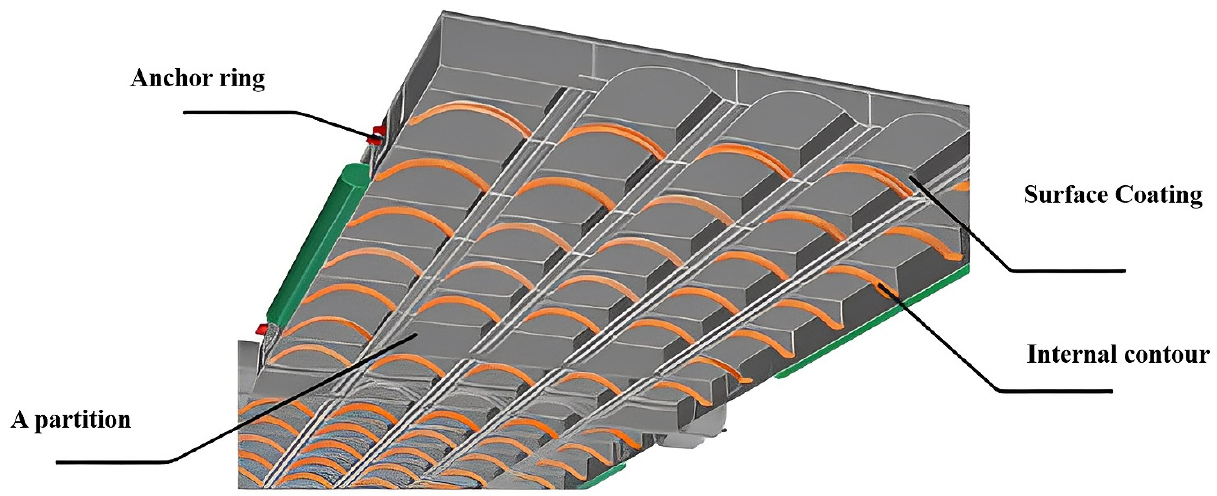
Figure 6. The internal structure of the bridge